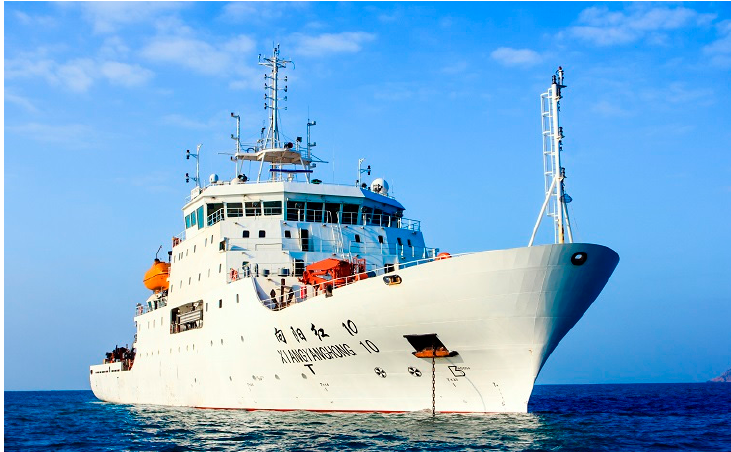
Figure 1. Survey carrier: Xiangyanghong No. 10 Vessel.